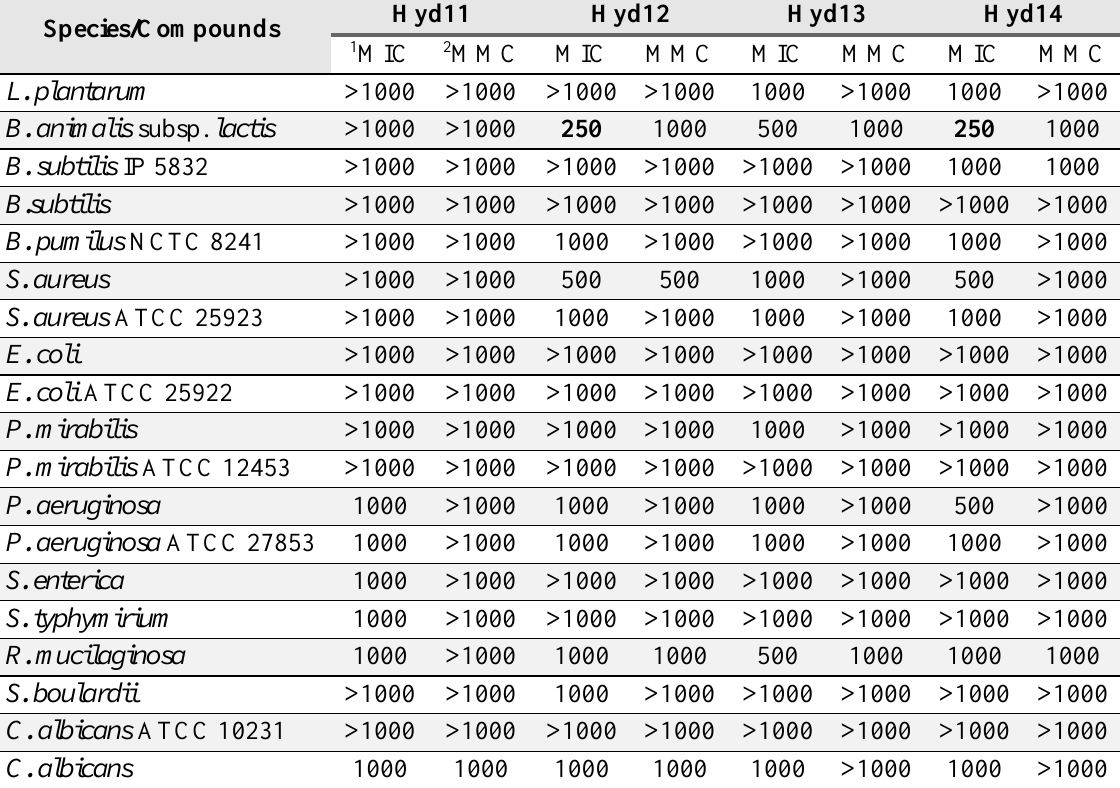
Table 3. Antimicrobial activity of acetylated hydantoin derivatives.